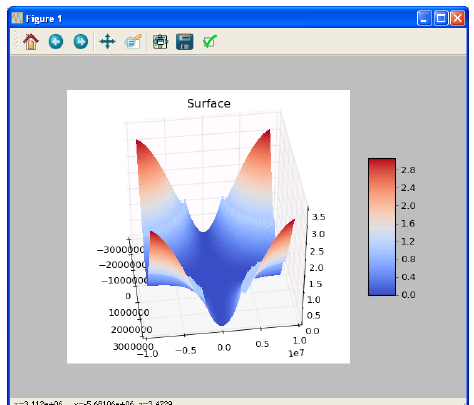
Fig. 10. The window of application of the Wolfram Fig. 9. The area of distortions in the Sanson demonstration (source: http://demonstrations.wol - projection